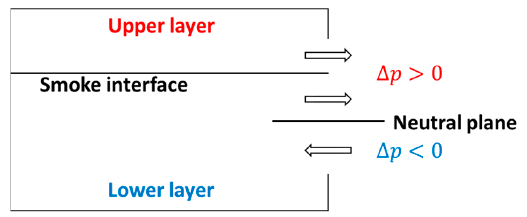
Figure 3. Example of vertical-vent configuration.